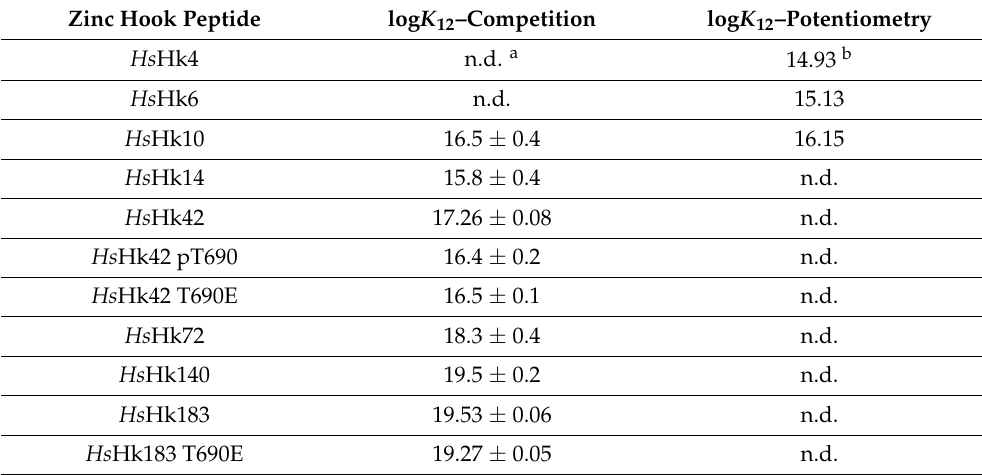
Table 1. Conditional formation constants (log K 12 ) of Zn( Hs Hk) 2 of human zinc hook peptides, their mutants, and phosphorylated variants at pH 7.4, I = 0.1 M, 25 ◦ C. Values were determined by competition experiments with zinc chelators with spectropolarimetric detection or calculated from cumulative protonation and stability constants determined by